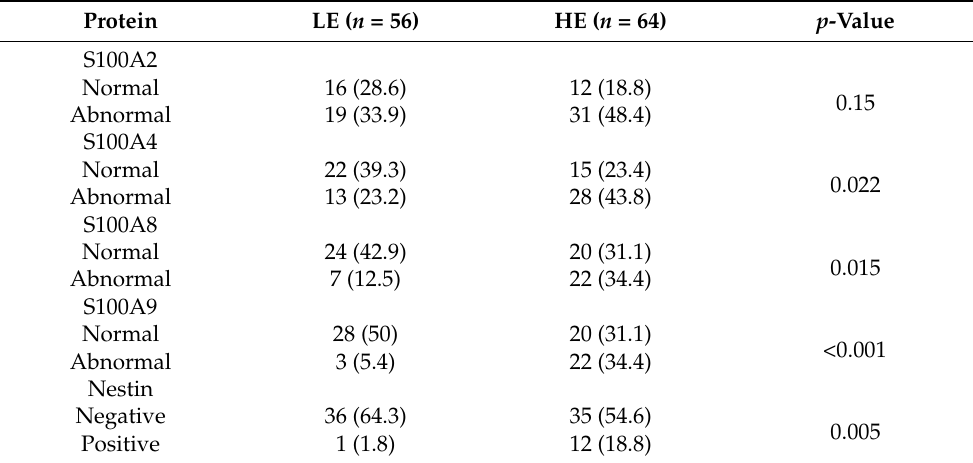
Table 4. Associations in patients between the two types of AHNAK2 expressions and S100A2, S100A4, S100A8, S100A9, and nestin. Statistically significant values are highlighted in